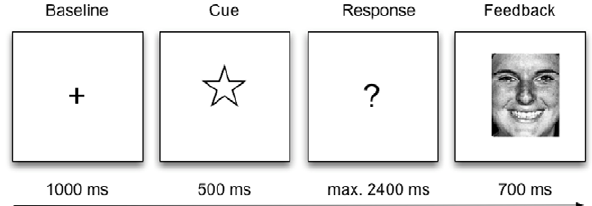
Figure 3. Time line of the gambling task. One of three visual cues (circle, triangle, star) was presented for 500 ms; subsequently, participants had to decide which of two buttons to press considering previously learned cue-response contingencies. After a delay of 400 ms, feedback was presented for 700 ms. Happy faces indicated positive and angry faces indicated negative